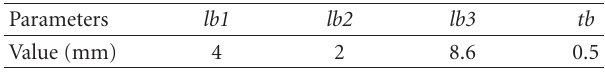
Table 2: Optimized geometry of the smaller C-shaped slot.